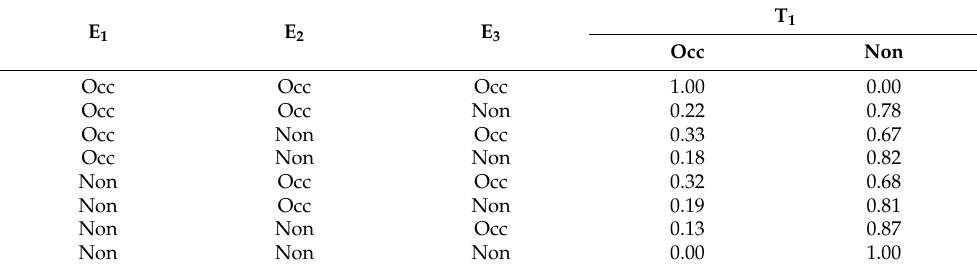
Table A9. The CPT of event T 1 (Gasifier abnormality; Occ: occurred; Non: